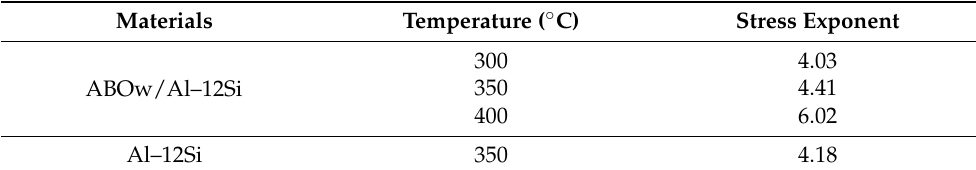
Figure 7. Plot of ln ε vs. ln σ for calculating the stress exponent for the ABOw/Al–12Si composite. Table 4. Values of stress exponent n for different composites.